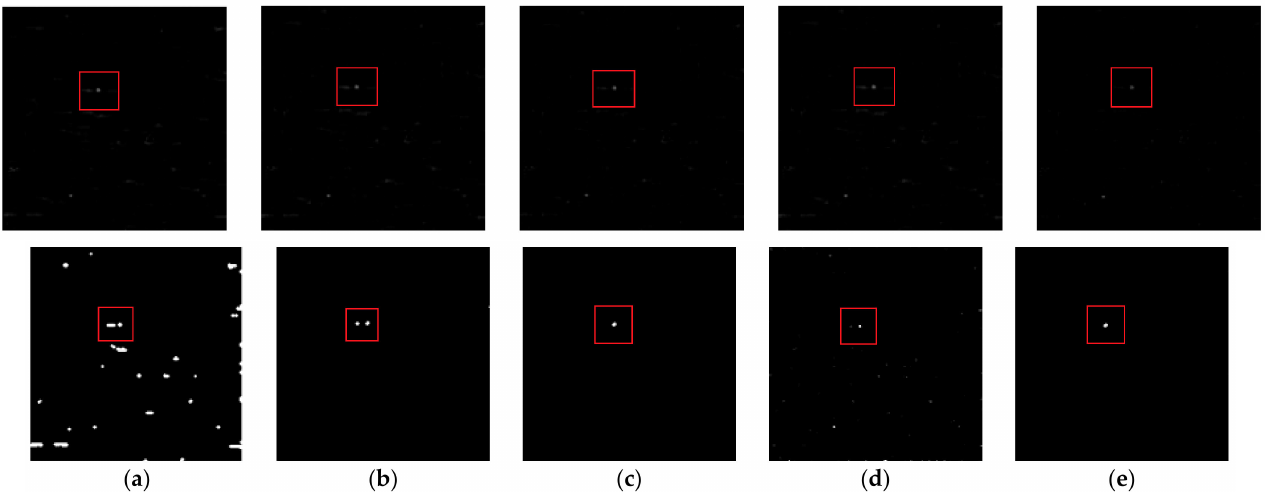
Figure 13. Weakly undulating sea clutter. ( a ) Top-hat. ( b ) Spatial dynamics. ( c ) Temporal dynamics. ( d ) Spatio-temporal filter. ( e ) Proposed algorithm.